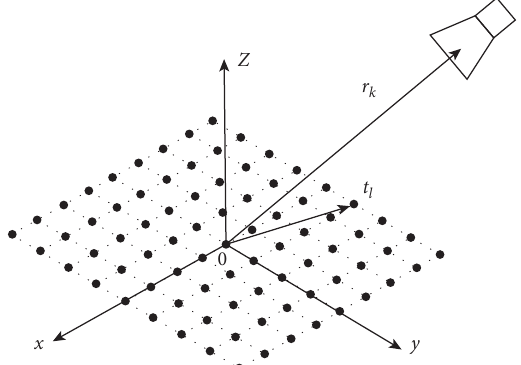
Figure 2: Simplified illustration of the grid used for the sampling of the imaging